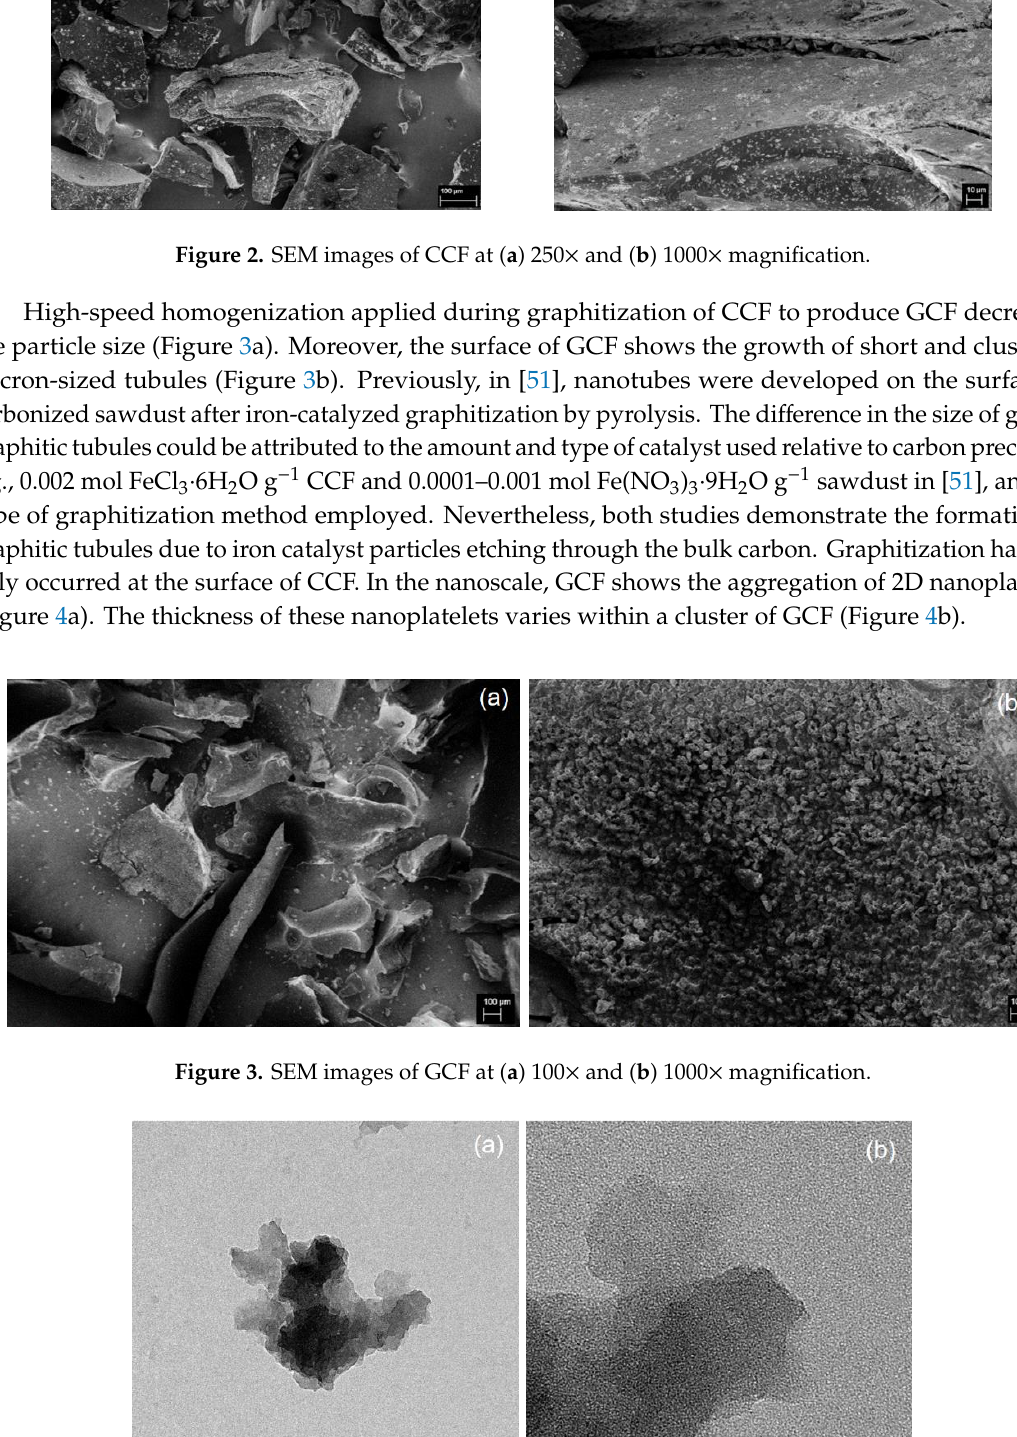
Figure 4. TEM images showing ( a ) a cluster of GCF composed of ( b ) aggregated 2D nanoplatelets.